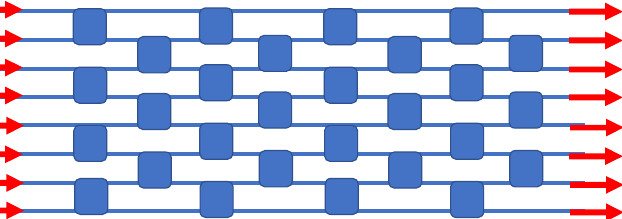
Figure 6. Block diagram of the monochromatic 8 × 8 Spanke–Benes permutation matrix switch. This diagram is based upon the layout of Figure 6b in [50].